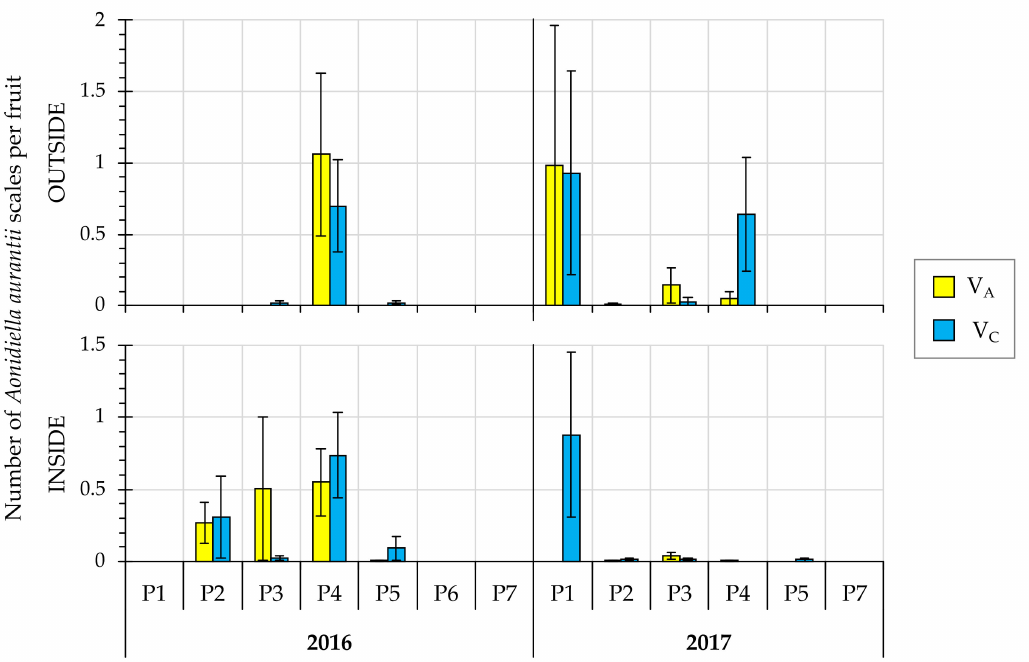
Figure 7. Number of Aonidiella aurantii scales per fruit (mean value with standard error bar) at two depths of the canopy (outside, inside), in function of the treatment (V A : adjusted volume, V C : conventional volume), for each plot (P1–P7) and year (2016 and